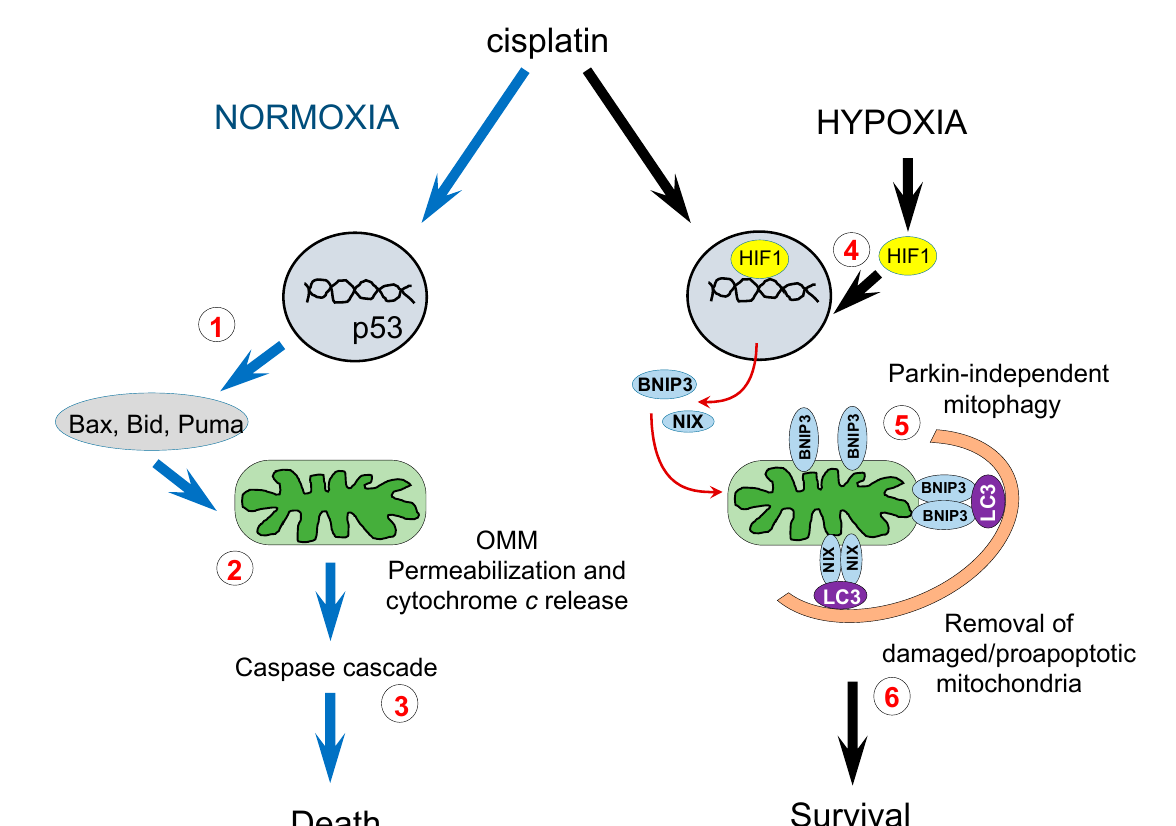
Figure 7. Cell survival under hypoxic conditions via activation of receptor-mediated mitophagy. See text for explanation.